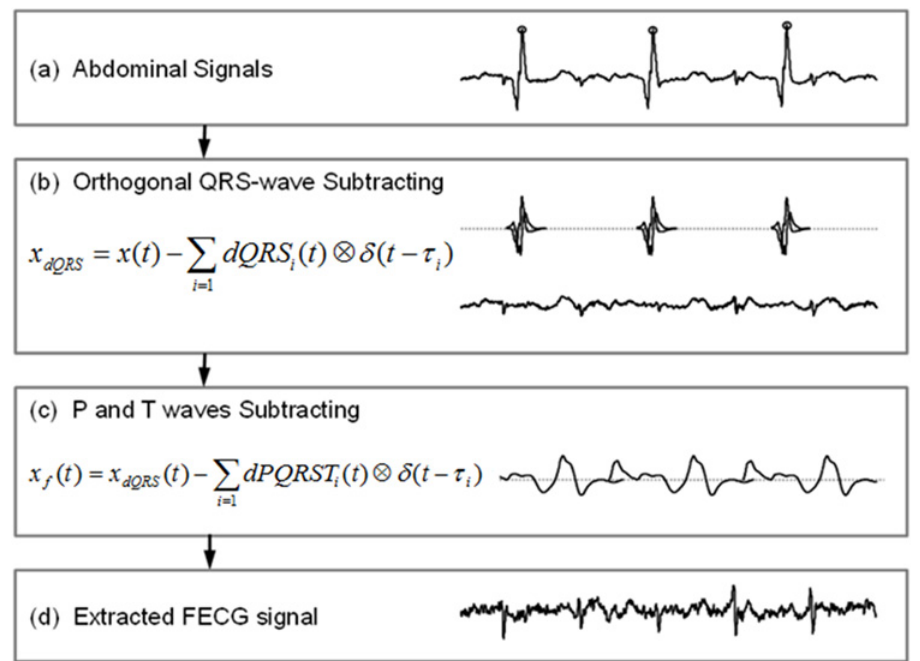
Fig 2. Illustrative maternal of ECG signals processed by the proposed algorithm step by step. (a) An example of raw data with maternal ECG interferences which could be suppressed significantly by the adaptive combination of two orthogonal QRS templates. (b) The maternal P and T waves still appear in the residues even when the QRS complexes are completely removed. (c) The subtraction of P and T waves can be simply implemented by removing the average of all P-T